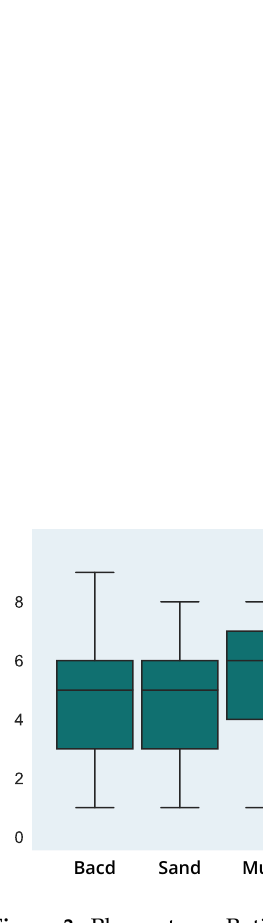
Figure 3. Pleasantness Ratings. The figure shows boxplots for pleasantness ratings (from 0 = extremely unpleasant to 9 = extremely pleasant) of different odor molecules. Rhombs display